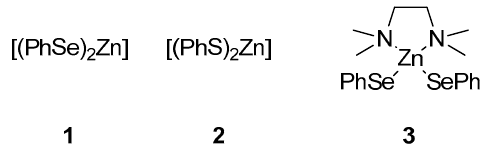
Figure 3. Reagents investigated in the present work. thiol ester 6a , was evaluated in “on water” conditions (Table 2, entries 10–12) and these results were compared with some data recently reported using other zinc selenates, as well as different reaction conditions (Table 2, entries 1–3, 5–9). The bis-phenylselenate ( 1 ) showed an interesting reactivity affording, after 30 min, the formation of 5a in 83% yield (Table 2, entry 10). This result confirms that zinc selenates, as previously reported, are efficient selenenylating reagents for the on-water acyl substitution. In addition, the use of water as medium for the reaction with the acyl chloride prevents the undesired ring opening of THF [56], affording diphenyl diselenide and benzoic acid as side organic products of residual decomposition, and TMEDA when 3 was used. Reasonably the zinc derivatives are removed during the workup due to their water solubility. We also observed that the